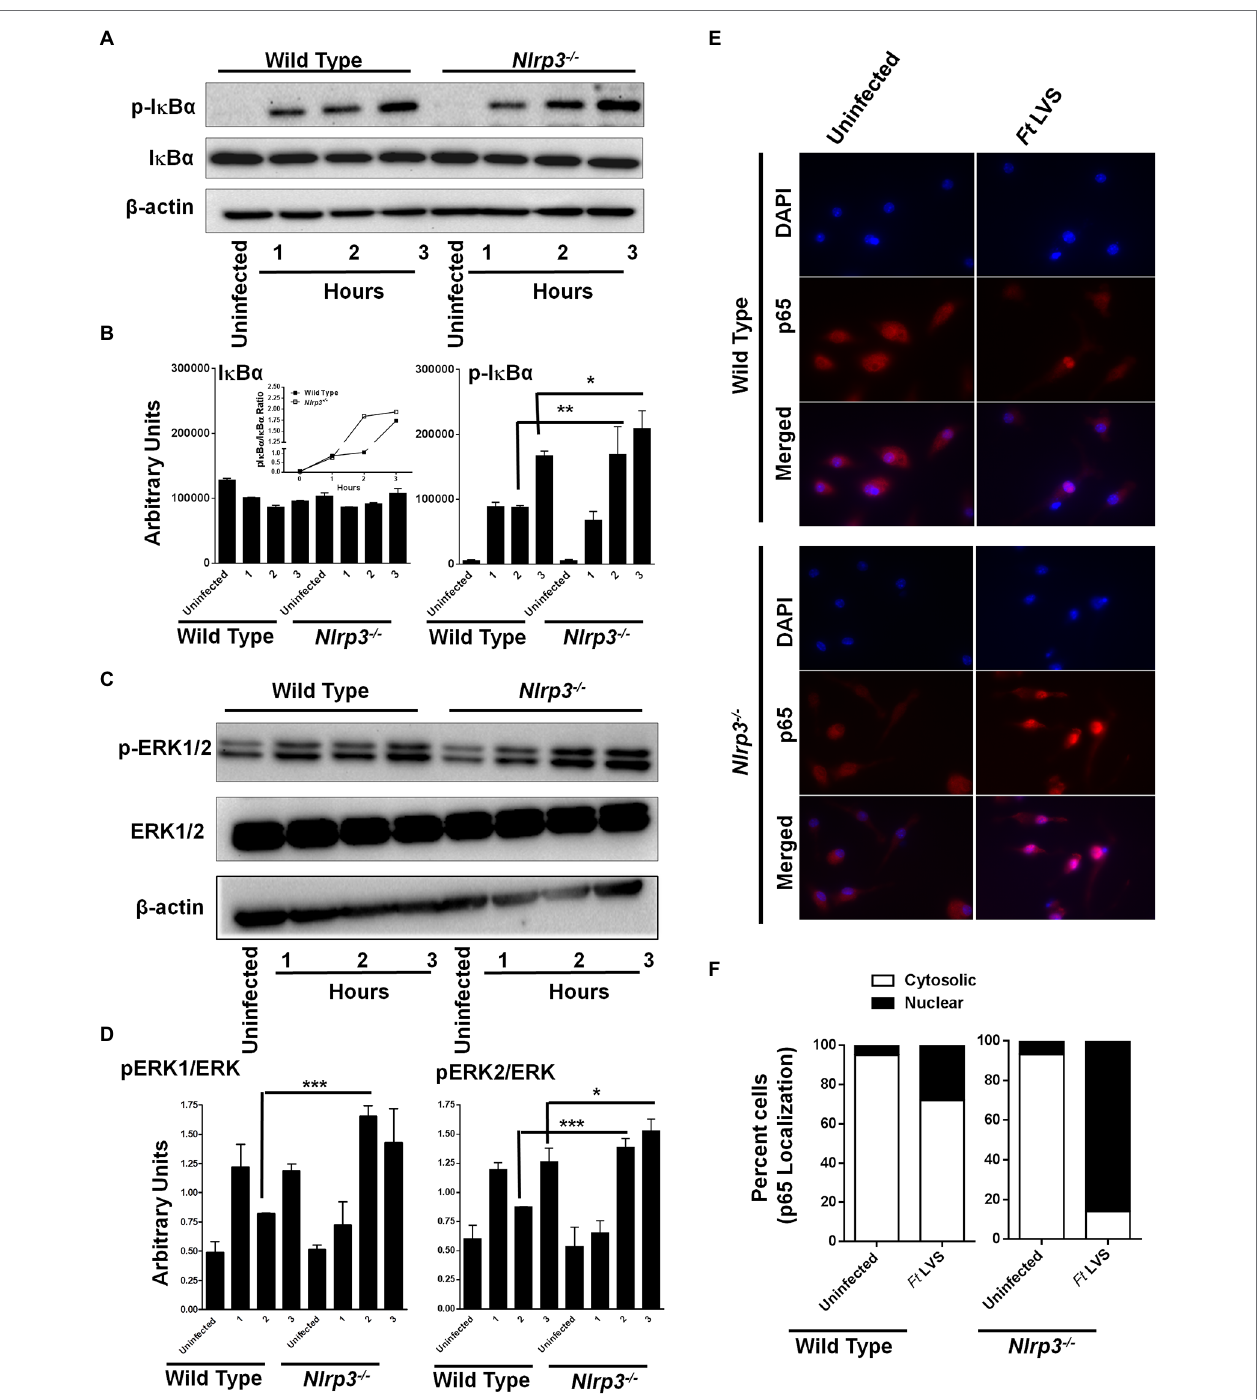
FIGURE 2 | Loss of Nlrp3 results in enhanced activation of NF- κβ and MAPK signaling. The wild-type and the Nlrp3 − / − macrophages were infected with 100 MOI of F. tularensis ( Ft ) LVS for the indicated times, lysed and separated by SDS-PAGE, and immunoblotted with phosphorylated (p) and total I κ B α - (A) and ERK1/2 (C) antibodies. β -actin was used as a loading control. Quantitation of I κ B α , p-I κ B α (B) , ERK, and p-ERK bands (D) ( n = 2 blots). Uninfected macrophages were used as controls. The inset in B shows pI κ B α /I κ B α ratios. The data were analyzed by one-way ANOVA, and a p- value of 0.05 or less was considered significant. * p < 0.05; ** p < 0.01; *** p < 0.001. (E) Immunofluorescence staining was performed to detect cellular localization of the p65 subunit of NF- κβ in the wild type or the Nlrp3 − / − macrophages infected with 100 MOI of Ft LVS (magnification 63×, red, p65; blue, nucleus). (F) Quantification of subcellular localization of p65 subunit of NF- κβ . At least 100 cells were counted manually in randomly selected fields. The results are expressed as percent macrophages showing cytosolic or the nuclear p65 localization. The data shown are representative of two independent experiments, each conducted with three biological